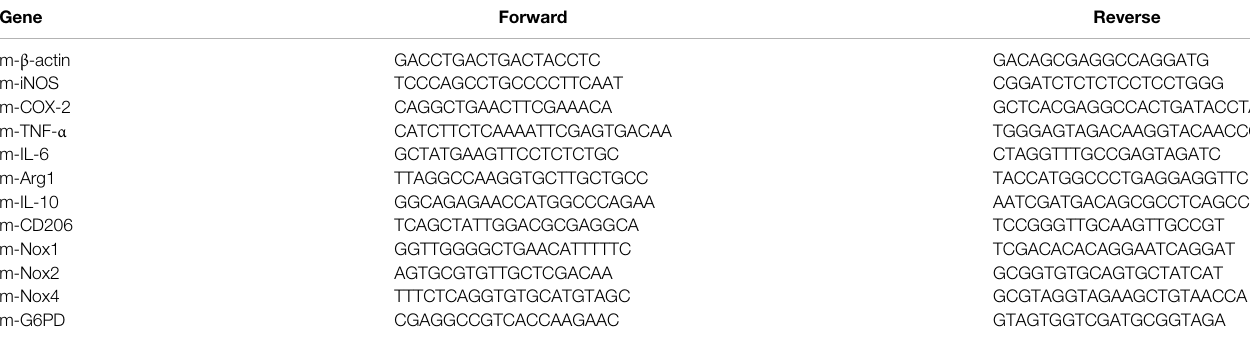
TABLE 2 | A list of primers sequences for RT-PCR